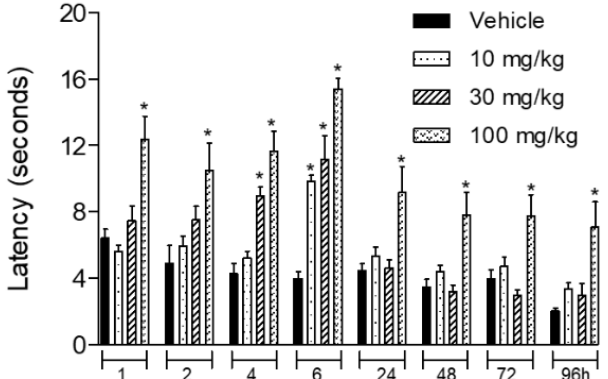
Figure 4. E ff ect of essential oil of Stevia serrata in the hyperalgesic e ff ect induced by carrageenan. The animals have been pretreated orally with the vehicle or essential oil (10, 30, 100 mg / kg) 1 h before intraplantar injection of carrageenan (1% / paw). Hyperalgesia has been evaluated in the hot plate model. Results are expressed as mean ± S.D. ( n = 6). Data have been analyzed by ANOVA, followed by Bonferroni post-test, * p < 0.05 has been considered as significant when compared to the vehicle-treated